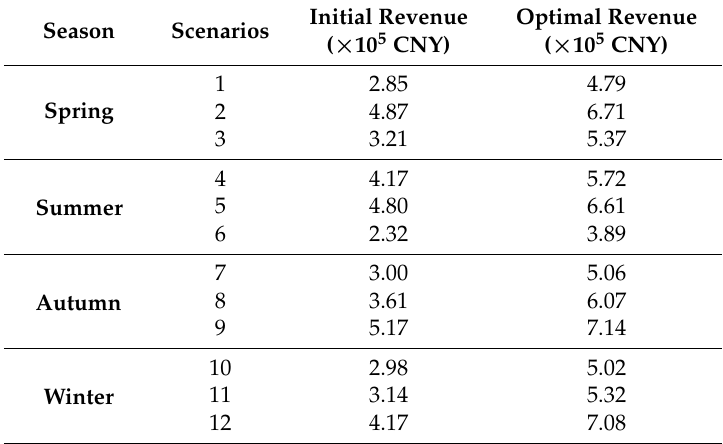
Table 6. Virtual power plant initial revenue and optimal revenue.